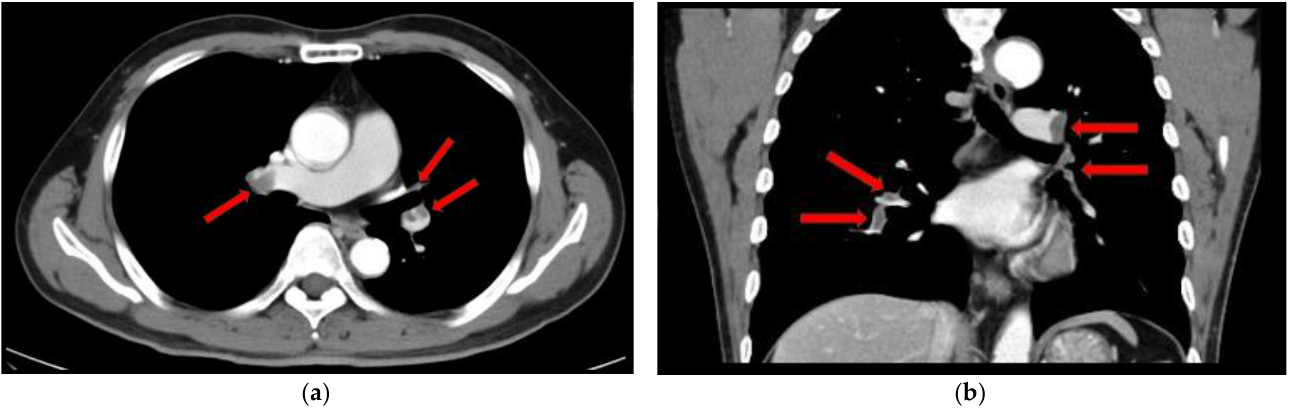
Figure 3. Chest contrast-enhanced computed tomography scan. Thrombi in the main trunk of the bilateral pulmonary arteries. ( a ) Axial view. ( b ) Coronal view. thrombus.